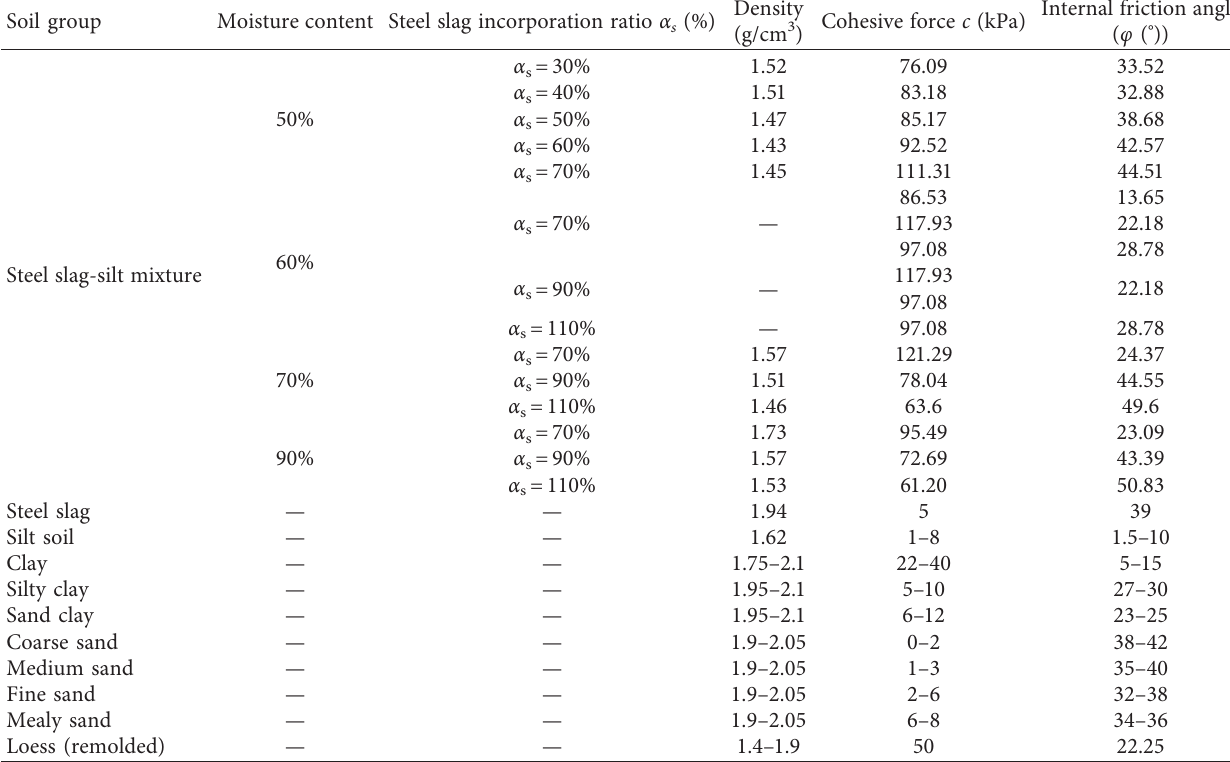
Table 8: Shear strength